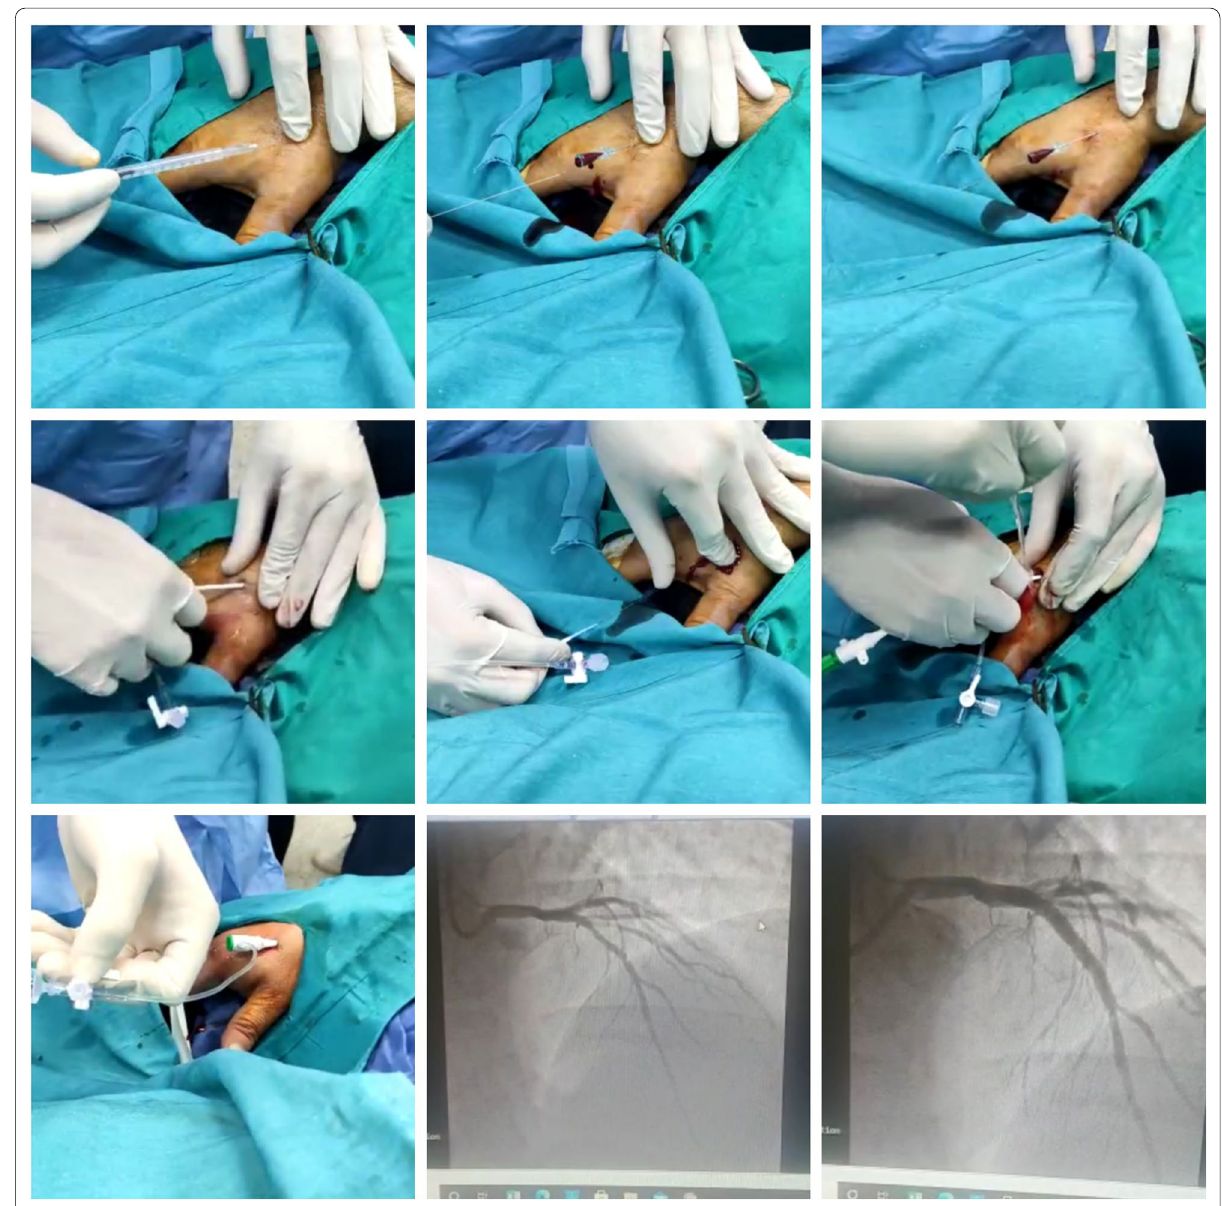
Fig. 1 A case of anterior MI was accessed successfully via right